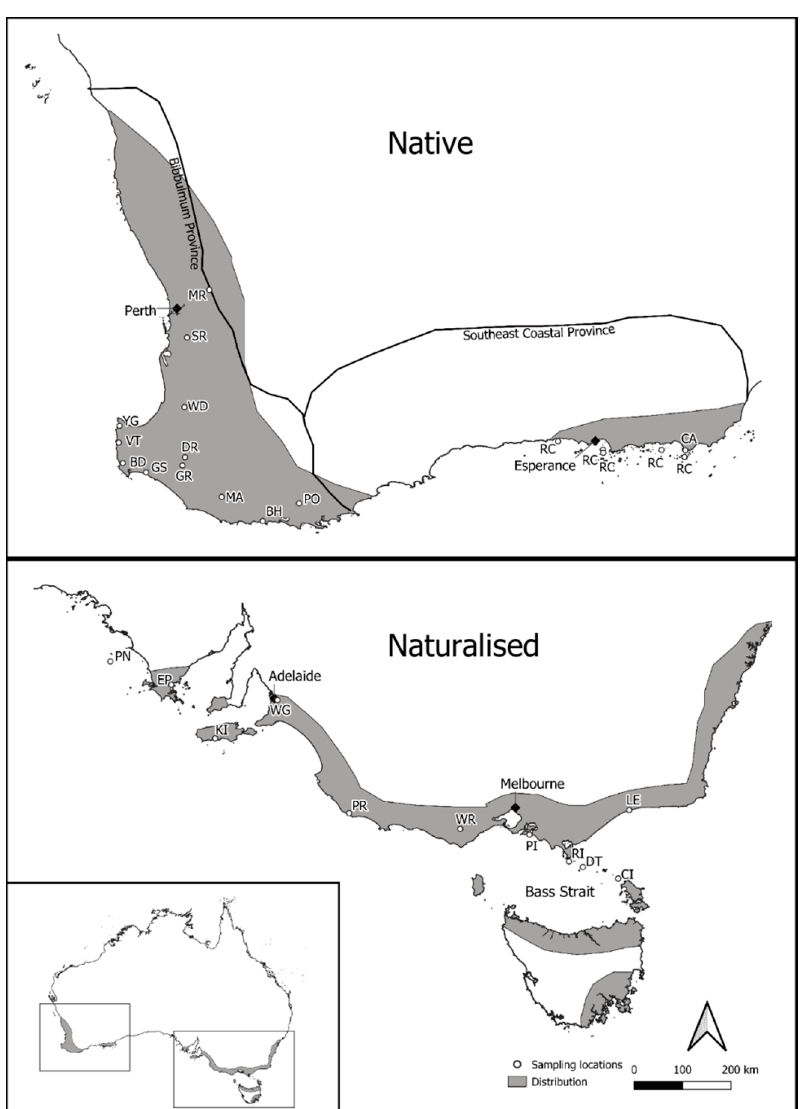
Figure 1. Dark gray areas show the broad extent of native and naturalized populations based on herbarium records on The Australasian Virtual Herbarium from 1826 to the present day. Small white circles show the location of sample sites. Approximate southwest Western Australia (SW WA) floristic provinces as per [27] indicated for the natural range. Details on population codes (e.g., PR and YG) can be found in Table 1.